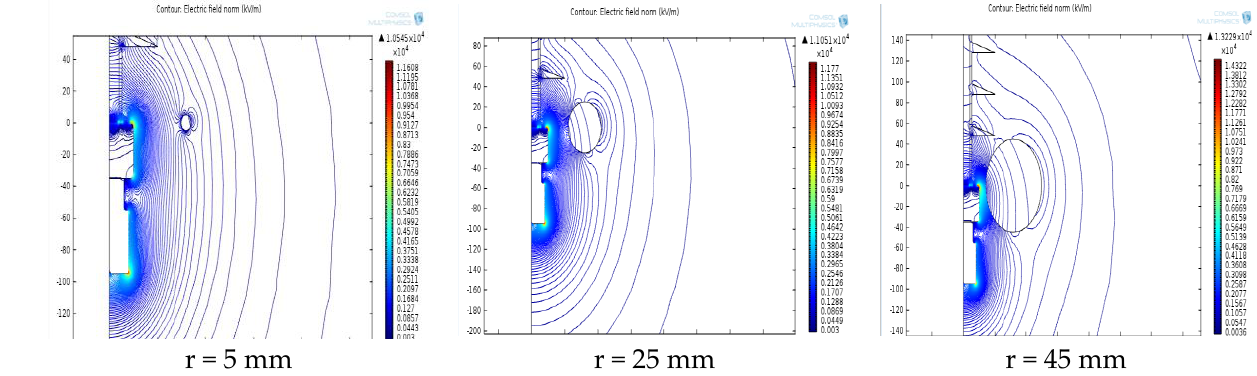
Figure 11. Electric field distribution with variation in diameter of ring tube, r.